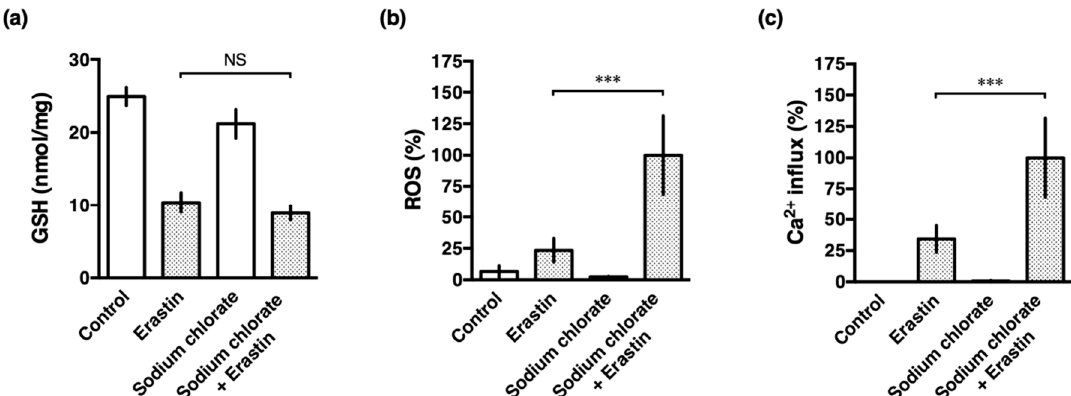
Figure 5. E ff ects of sodium chlorate on GSH contents, ROS production, and Ca 2 + influx in erastin-treated HT22 cells. The cells were treated with 0.2 µ M erastin in the presence or absence of 20 mM sodium chlorate for 8 h. ( a ) Glutathione contents were measured and normalized to the protein concentration. ( b ) ROS production was determined with MitoSOX reagent. ( c ) Intracellular Ca 2 + was detected with Fluo-4 reagent. The data are presented as the mean ± SD. The data were obtained from at least three independent cultures. *** p < 0.001; NS, not significant.